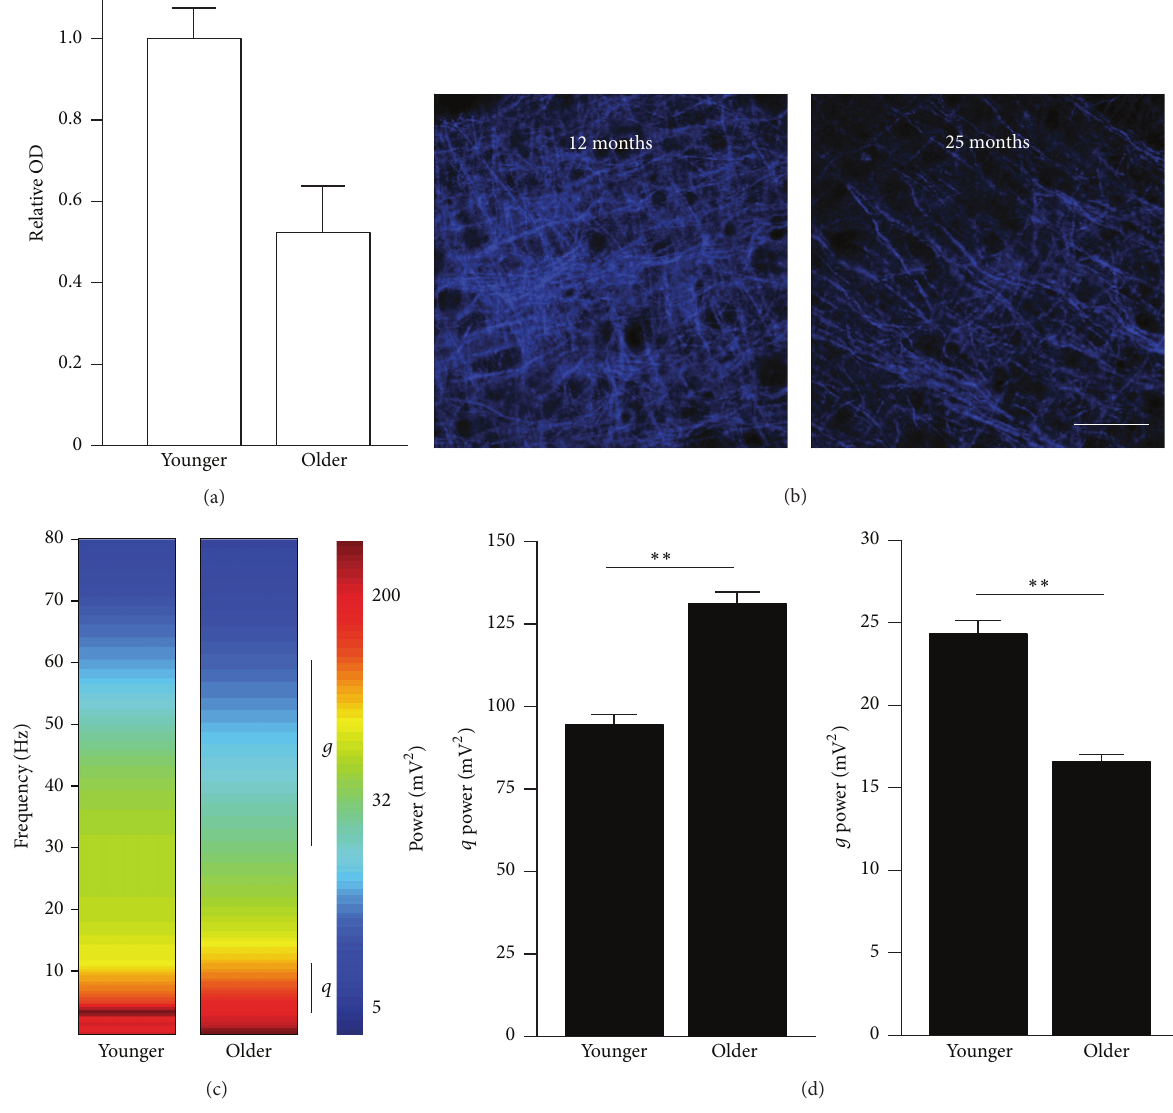
Figure 1: Reduction in Choline Acetyl Transferase (ChAT) and gamma activity in the older A1. (a) Average density of ChAT staining in young and older A1 determined by immunohistofluorescence (primary Ab: anti-ChAT; secondary Ab: AF647). (b) High power (40x) photomicrograph showing staining for ChAT in layer 4 of A1 in one younger (12-month-old) and one older (25-month-old) rat. (c) Power spectral density of local field potential (LFP) signals recorded during the presentation of tone pips in younger and older rats. The theta ( 𝜃 ) and gamma ( 𝛾 ) range is shown by vertical black bars. (d) Average theta (left) and gamma (right) band power in the LFP signals recorded in younger and older A1 during pure tone presentation. Note the relative increase in theta and decrease in gamma consistent with loss in cholinergic tone in A1 (younger: 𝑛 = 6 , recorded sites for LFP = 586, hemispheres examined for ChAT staining, 𝑛 = 8 , and number of photomicrographs analyzed, 𝑛 = 24 ; older: 𝑛 = 5 , recorded sites for LFP = 476, hemispheres examined for ChAT staining, 𝑛 = 8 , and number of photomicrographs analyzed, 𝑛 = 24 ). Scale bar: 50 𝜇 m. Values shown are mean ± SE. ∗ 𝑝 < 0.05 : ∗∗ 𝑝 < 0.01 : 𝑡